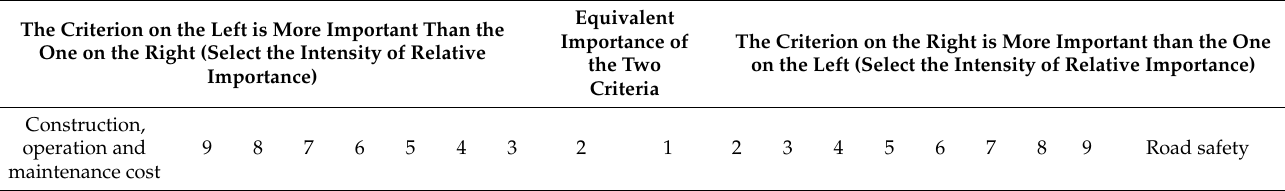
Table 2. Indicative part of criteria pair-wise